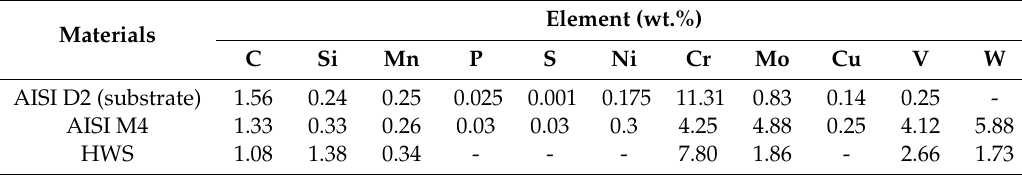
Figure 1. Micro-images of ( a ) M4 and ( b ) HWS (high-wear-resistance steel) spherical powders. Table 1. Chemical compositions of materials used (wt.%).